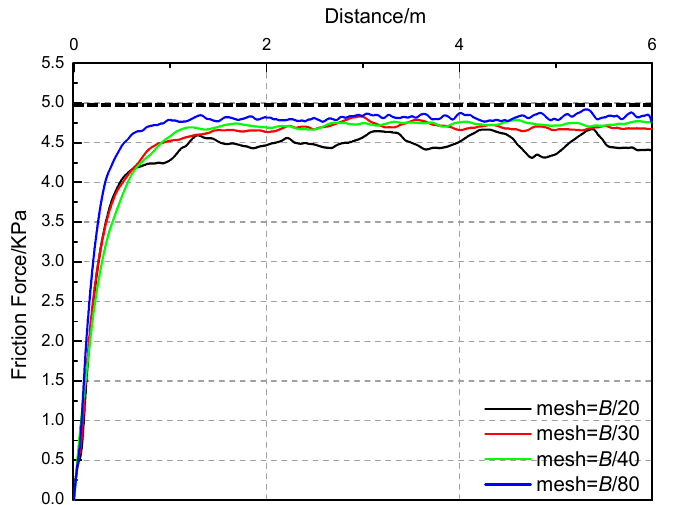
Figure 11. Numerical friction force in test model.